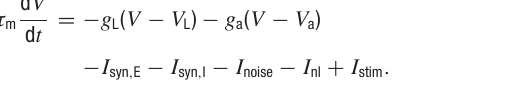
Figure 1. (A) nonlinear membrane current . The combination of a nonlinear intrinsic current, such as a cubic nonlinearlity with a single real root (dashed line) and a linear “external” contribution (dotted line) can give rise to an effec- tive bistability (solid line). In this example, the linear term has an excitatory effect. B-C: bistability and disorder. In both panels, the solid line is the current I nl computed using the mean values of ˜ V 1 , ˜ V 2 , and ˜ V 3 . (B) ˜ V 3 was given the maximal (dotted line) and minimal (dashed line) values of its distribution; the black segment denotes the corresponding interval, ( − 46, − 42) mV. The threshold of the membrane potential takes values in the interval ( − 45, − 41) mV (red segment). (C) ˜ V 2 was given the maximal (dashed line) and minimal (dotted line) values of its distribution; the black segment denotes the corre- sponding interval, ( − 60, − 56) mV. The reset potential takes values in the interval ( − 56, − 52) mV (red segment). In the legend, c is a